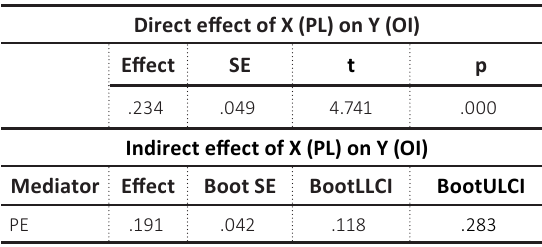
Table 4. Mediating effect of positive affect in the relationship between positive leadership and organizational identification